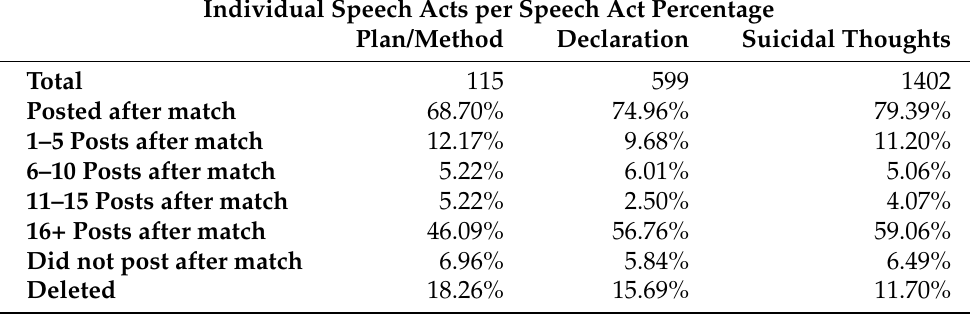
Table 5. User activity breakdown for critical speech